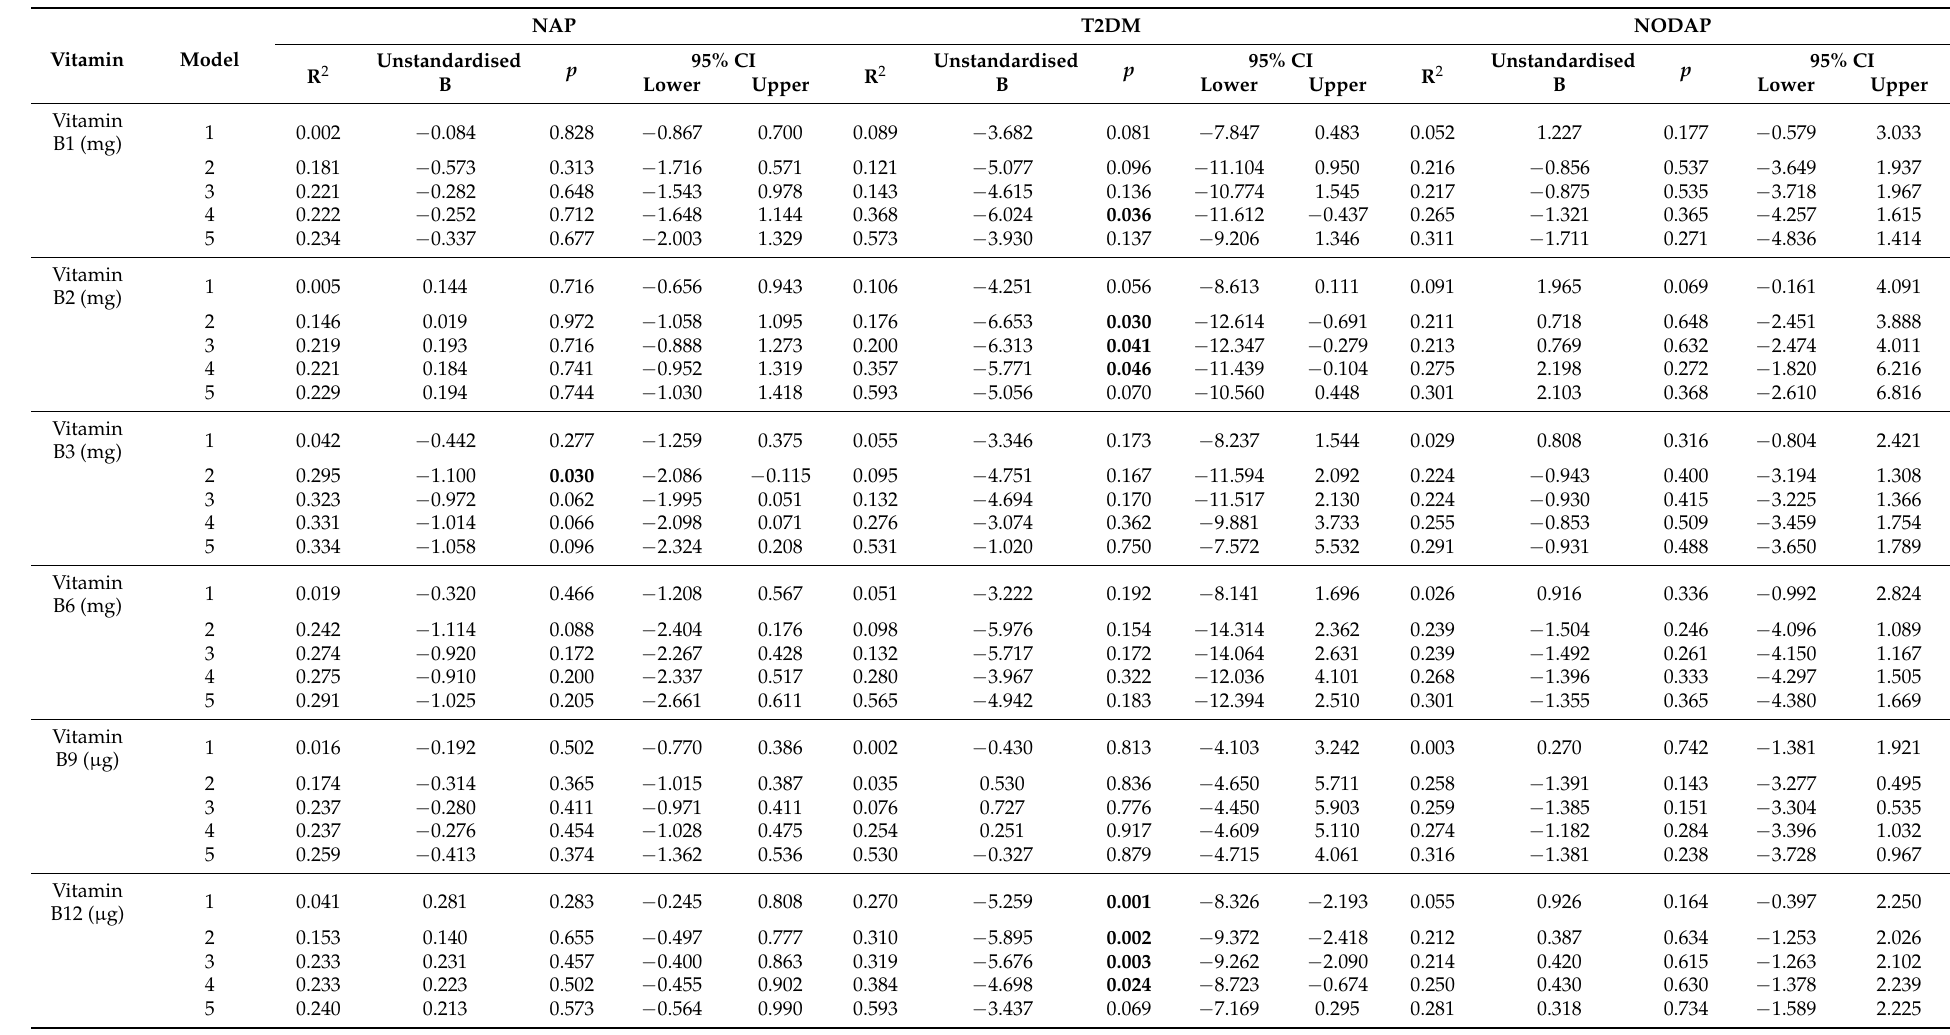
Table 4. Associations between habitual water-soluble vitamin intake and fasting plasma glucose in the study